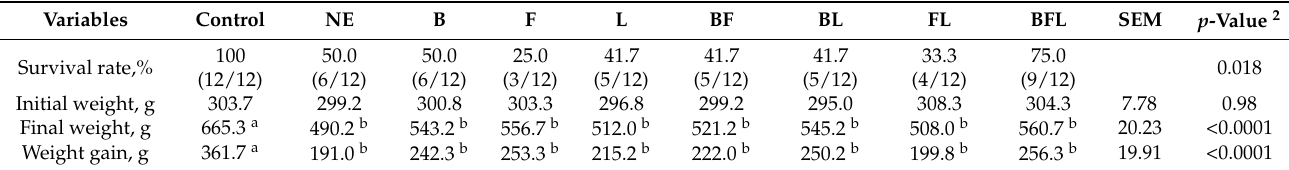
Figure 3. Induction of major barrier function genes by butyrate, forskolin, and lactose. Chicken HD11 cells were treated in triplicate with 2 mM butyrate, 5 μ M forskolin, and 0.1 M lactose alone or in different combinations for 24 h, followed by RT-qPCR analysis of the expressions of claudin 1 ( CLDN1 ) ( A ), CLDN5 ( B ), tight junction protein 1 ( TJP1 ) ( C ), and mucin 2 ( MUC2 ) ( D ). Results are presented as means ± SEM of three independent experiments. Means not sharing a common letter are significantly different ( p < 0.05; one-way ANOVA and post hoc Tukey’s test). Table 1. Survival rate and weight gain of chickens with necrotic enteritis 1 .